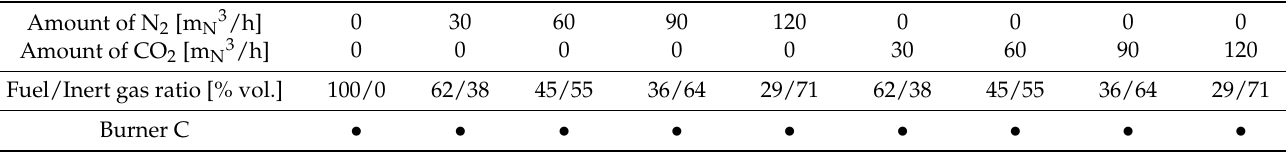
Table 6. Experimental matrix—TEST A—Burner C ( • indicates that the test was carried out).